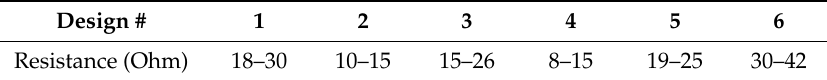
Table 3. The range of the initial resistance of the evaluated patterns. Design #